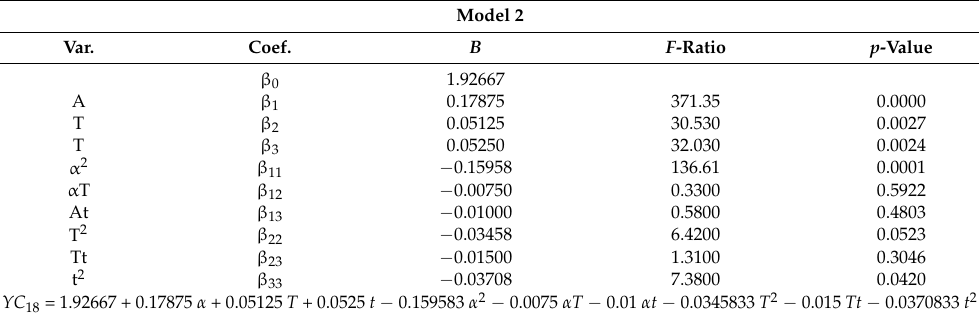
Figure 6. 3D response surface for n -C 17 yield combining: ( a ) T , W , S , and V; ( b ) t , W , S , and V . Table 6. Statistical coefficients for n -C 18 yield (mol %) and their statistical